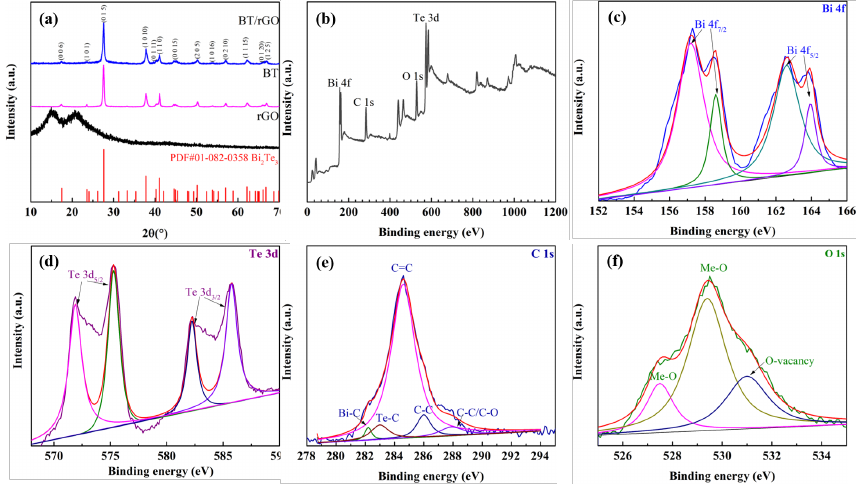
Figure 2. ( a ) XRD analysis of rGO, BT nanosheets, and BT/rGO. ( b ) XPS profile of BT/rGO. High- resolution ( c ) Bi 4f, ( d ) Te 3d, ( e ) C 1s, and ( f ) O 1s XPS